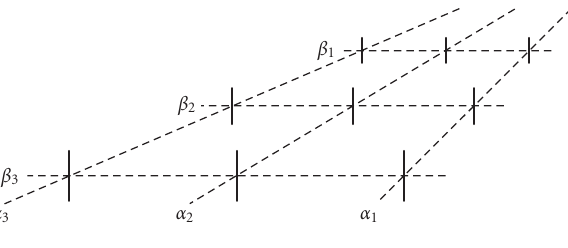
Figure 2.3. A fragment of the auxiliary square